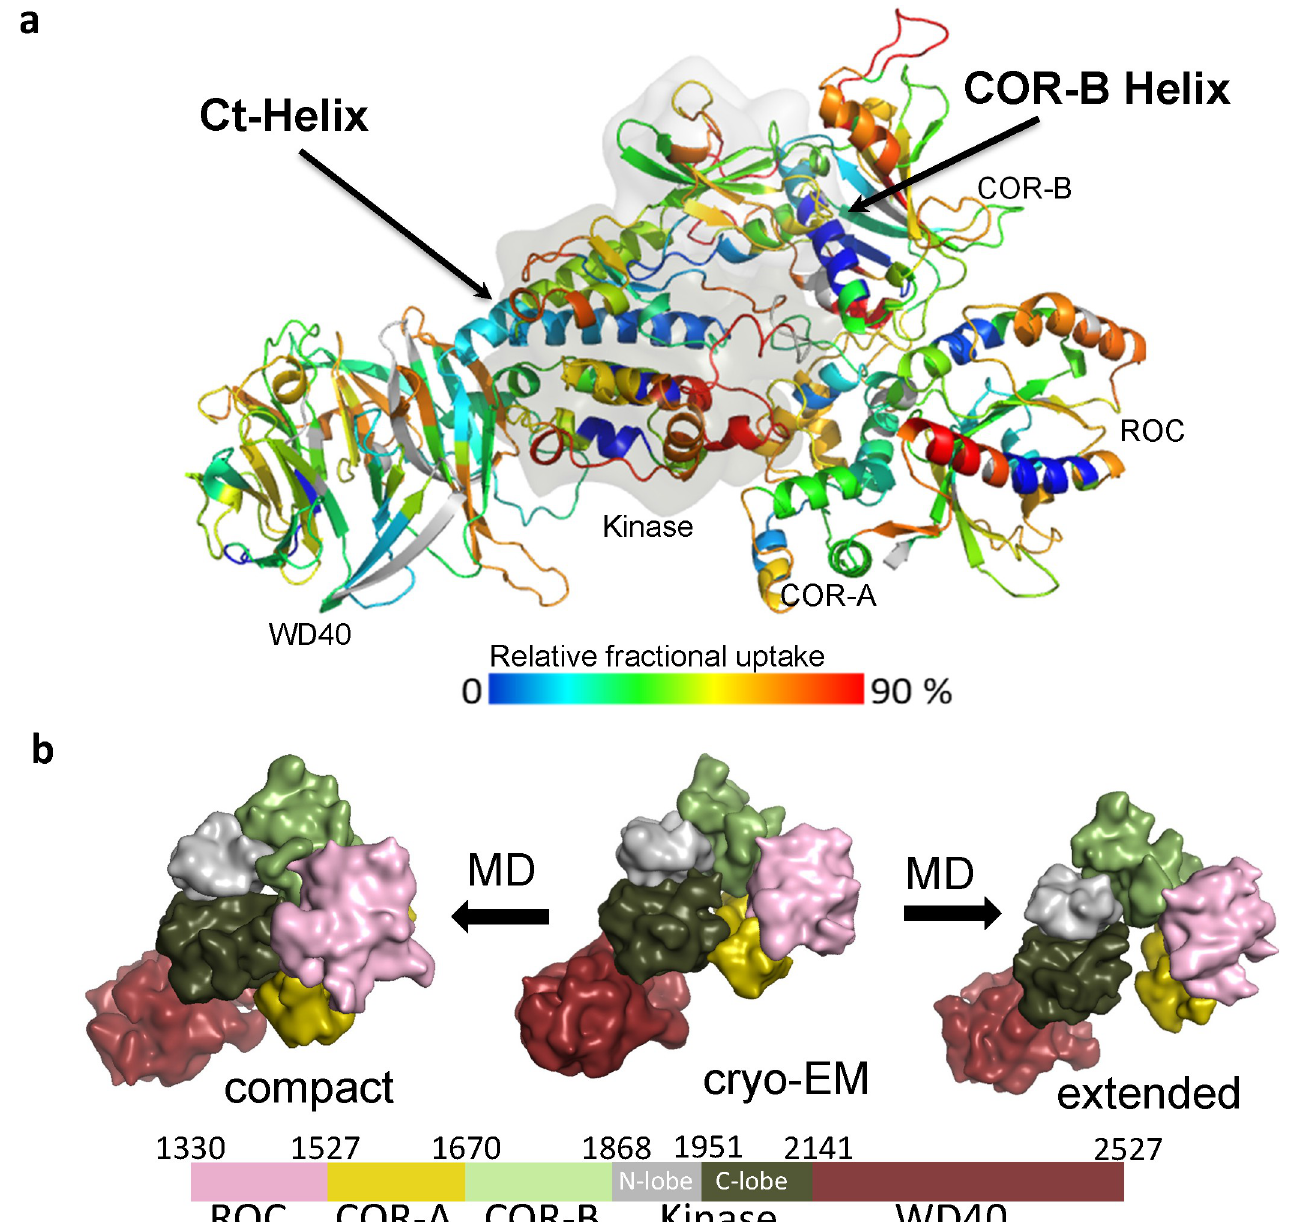
Fig 1. The overall dynamic of LRRK2 RCKW . (a) The relative deuterium uptake after 2-min deuterium exposure is color-coded mapped on the LRRK2 RCKW model. Gray color indicates no deuterium uptake information. The surface of the kinase domain is shown in gray. The highly protected COR-B Helix and the Ct-Helix located at the back of the kinase domain are labeled. (b) Snapshot of LRRK2 RCKW in the MD simulation. The surface of each domain is shown in different colors. Left represents the compact architecture of LRRK2 RCKW . The middle is the structure from cryo-EM (PDB: 6VNO) [10]. The right represents one of the extended states of LRRK2 RCKW . cryo AU : AbbreviationlistshavebeencompiledforthoseusedinFigs 1 (cid:0) 8 : Pleaseverifythatallentriesarecorrect : -EM, cryogenic electron microscopy; Ct-Helix, C-terminal helix; MD, molecular dynamics; ROC, ras-of-